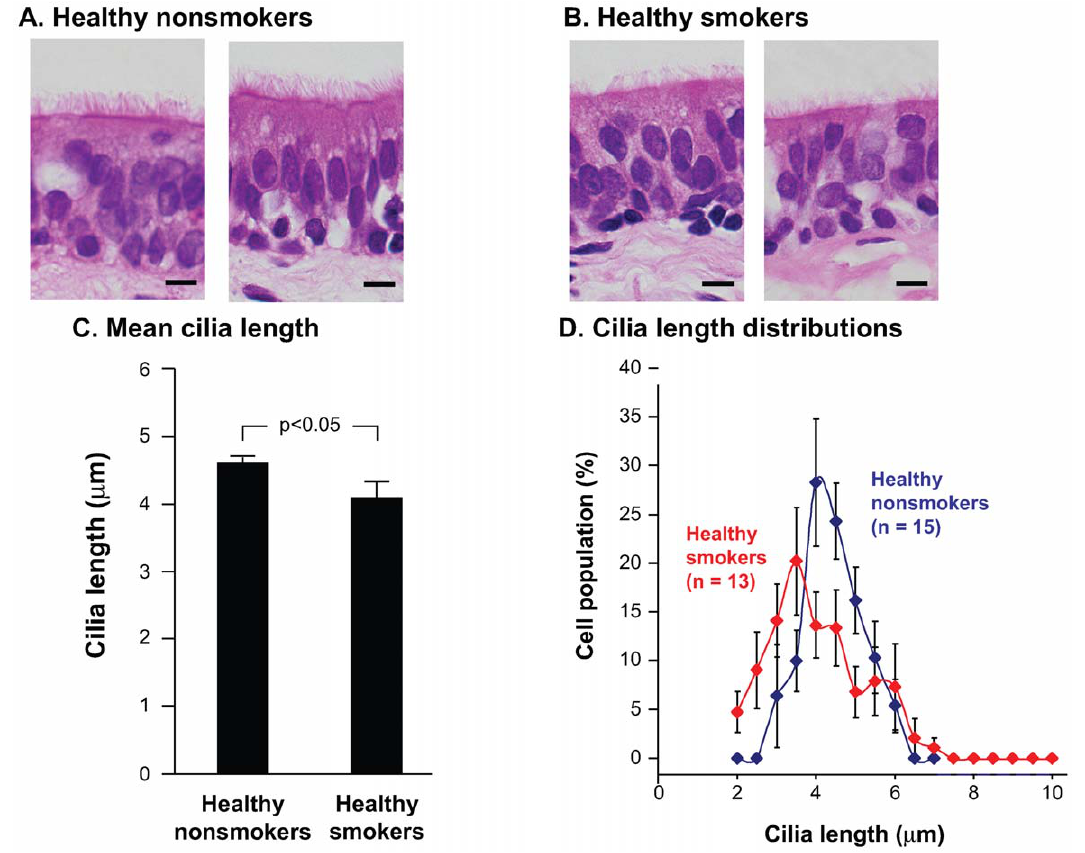
Figure 1. Cilia length in normal smokers and nonsmokers measured in fixed, paraffin-embedded endobronchial biopsies. Endobronchial biopsies were fixed in 4% paraformaldehyde, processed for paraffin embedding, sectioned at a thickness of 5 m, and stained with hematoxylin and eosin. Brightfield images were evaluated for cilia length. (A) Endobronchial biopsy morphology in normal nonsmokers. Bar =10 m. (B) Endobronchial biopsy morphology in normal smokers. Bar =10 m. (C) Mean cilia length within the study populations. Shown are the mean standard error of cilia lengths for nonsmokers (n=15) and smokers (n=13). Between 4 and 13 individual measurements were made per study individual (median =7). (D) Distribution of cilia lengths in airway epithelial cells from normal nonsmokers and normal smokers. Distributions were constructed by creating histograms from 0.5 micron bins and then equally weighting each study individual.